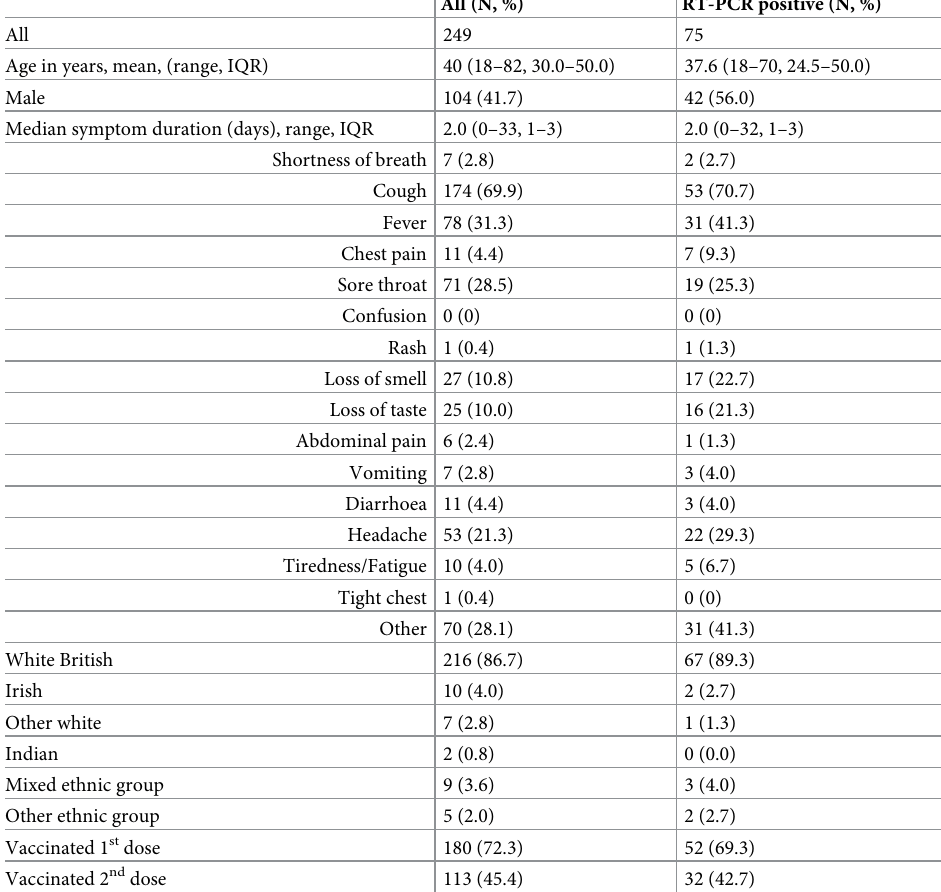
Table 1. Characteristics of